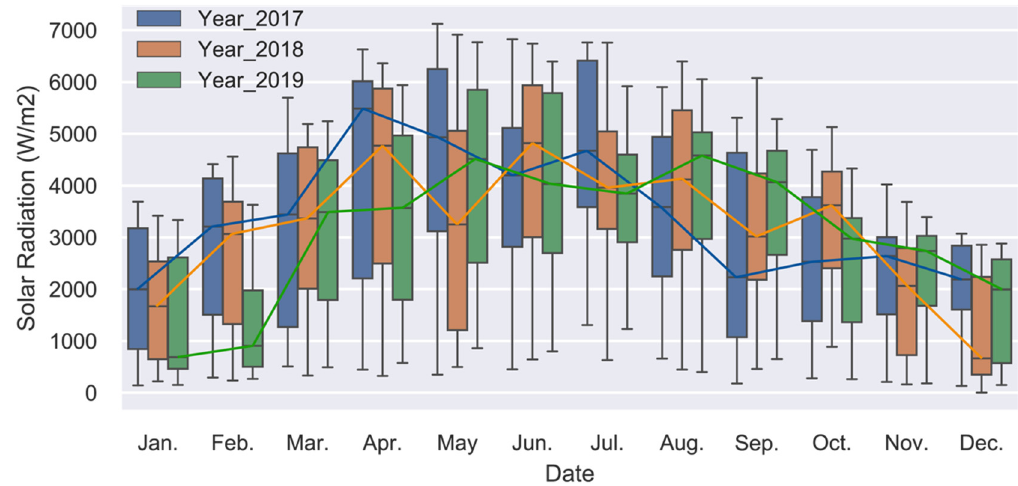
Figure A6. The distribution of sum of daily solar radiation for three years.